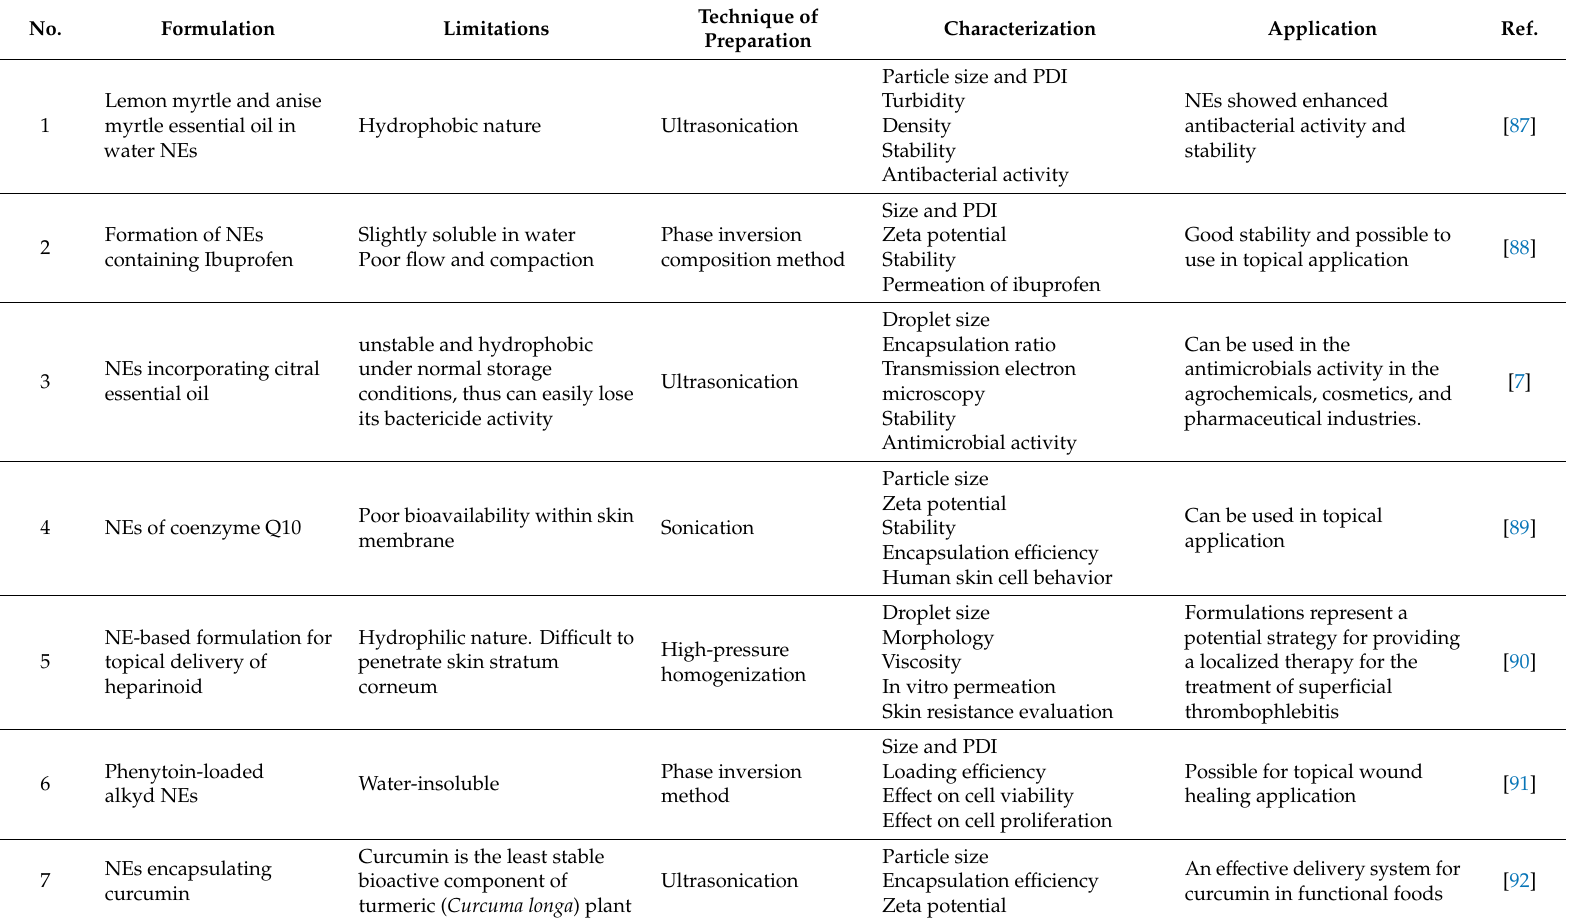
Table 3. The formation of NEs and their applications in